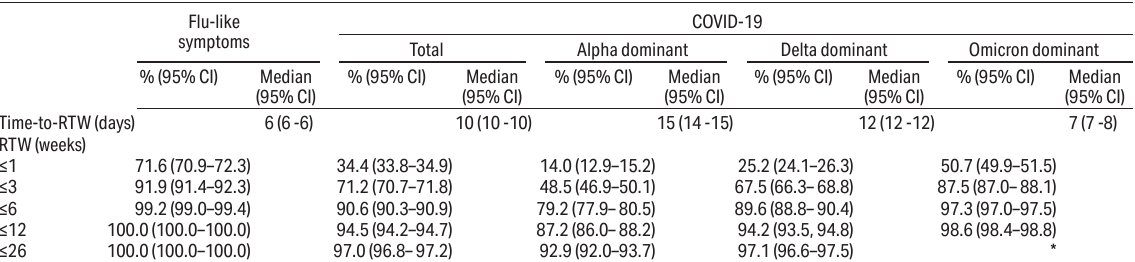
Table 2. Probability of returning to work after COVID-19 at various return-to-work (RTW) rates and in time periods with different dominant virus vari - ants. The sample for flu-like symptoms and the total COVID-19 sample include observations with first day of absence between 19 March 2020 and 18 March 2022. The other samples include observation with first day of absence between 15 February 2021 and 27 June 2021 (alpha